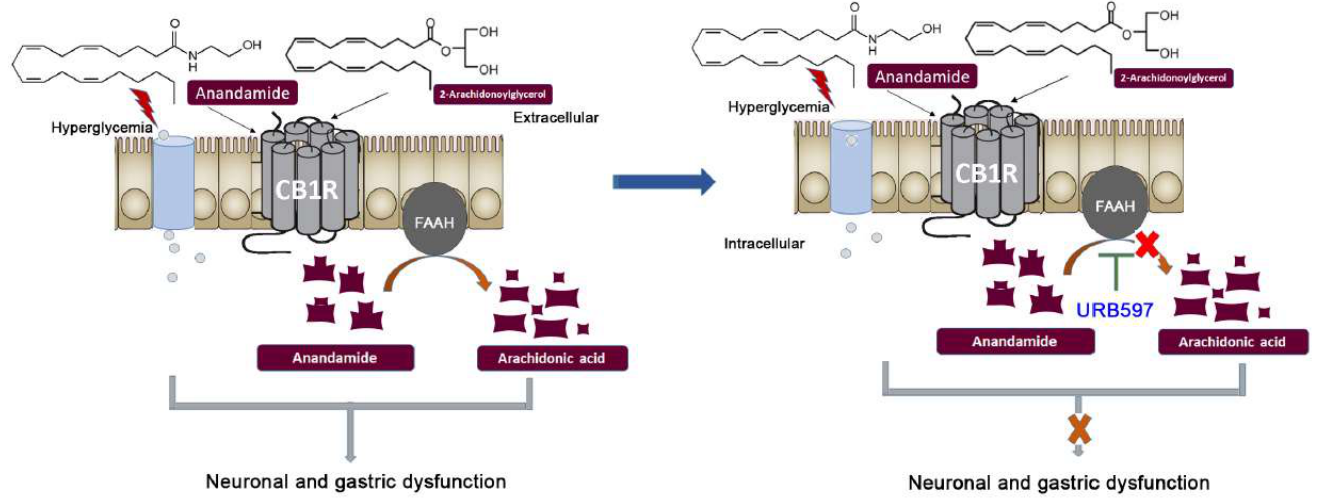
Figure 3. This schematic presentation depicts that natural endocannabinoid anandamide activates the receptors CB1 in the membrane of the ileum and distal colon. The enzyme FAAH breaks down anandamide immediately after use, whereas this study shows that inhibiting FAAH with URB597 results in significant improvement suggesting a CB1-mediated mechanism.